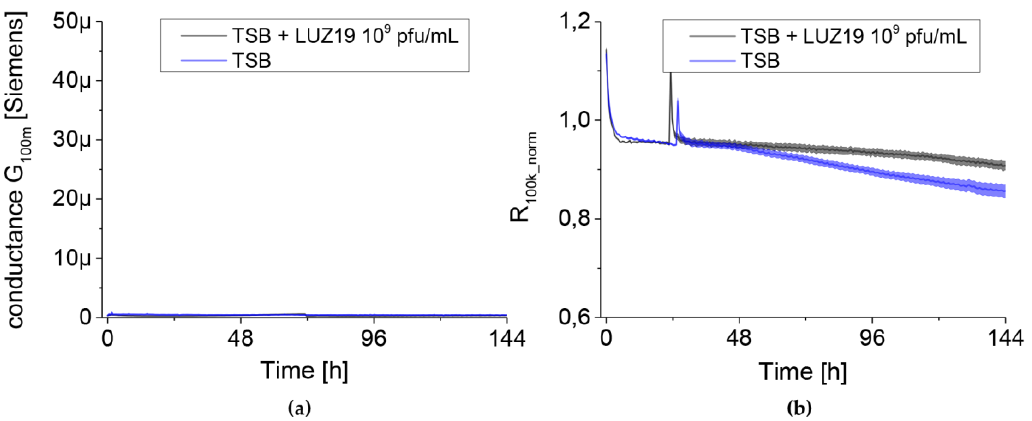
Figure 7. The changes in conductance G 100m (left panel) and resistance R 100k_norm (right panel) measured by QTF sensors for negative control consisted of phage LUZ19 and TSB medium. Data are expressed as mean conductance G 100m ± SD and R 100k_norm of four independent experiments.